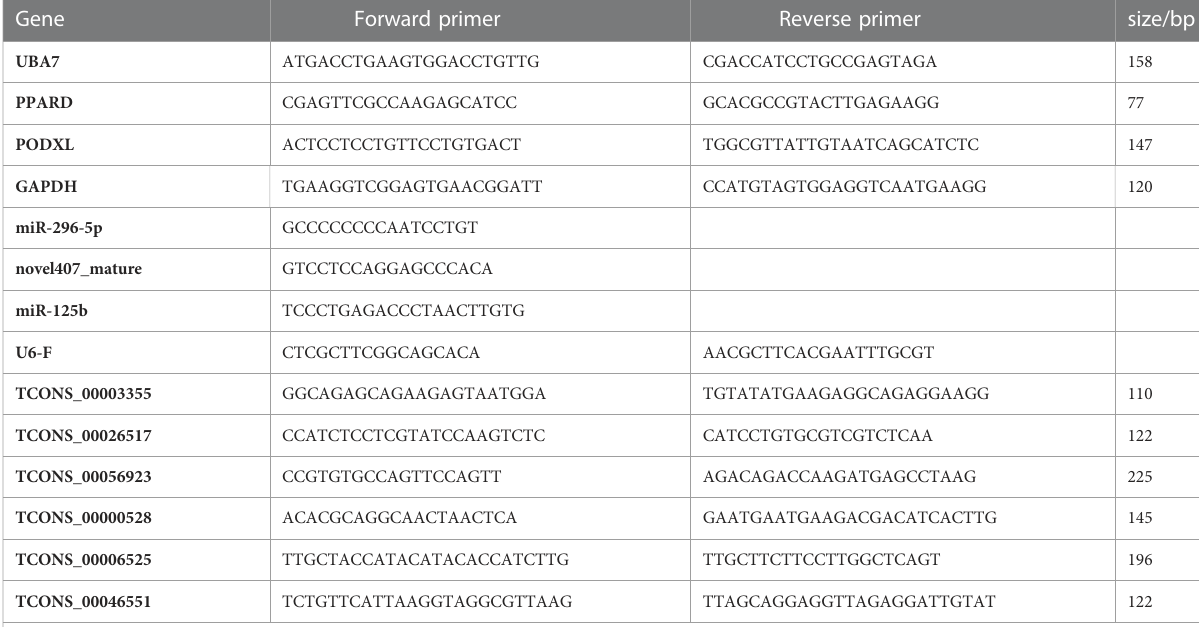
TABLE 1 Genes and the corresponding primer